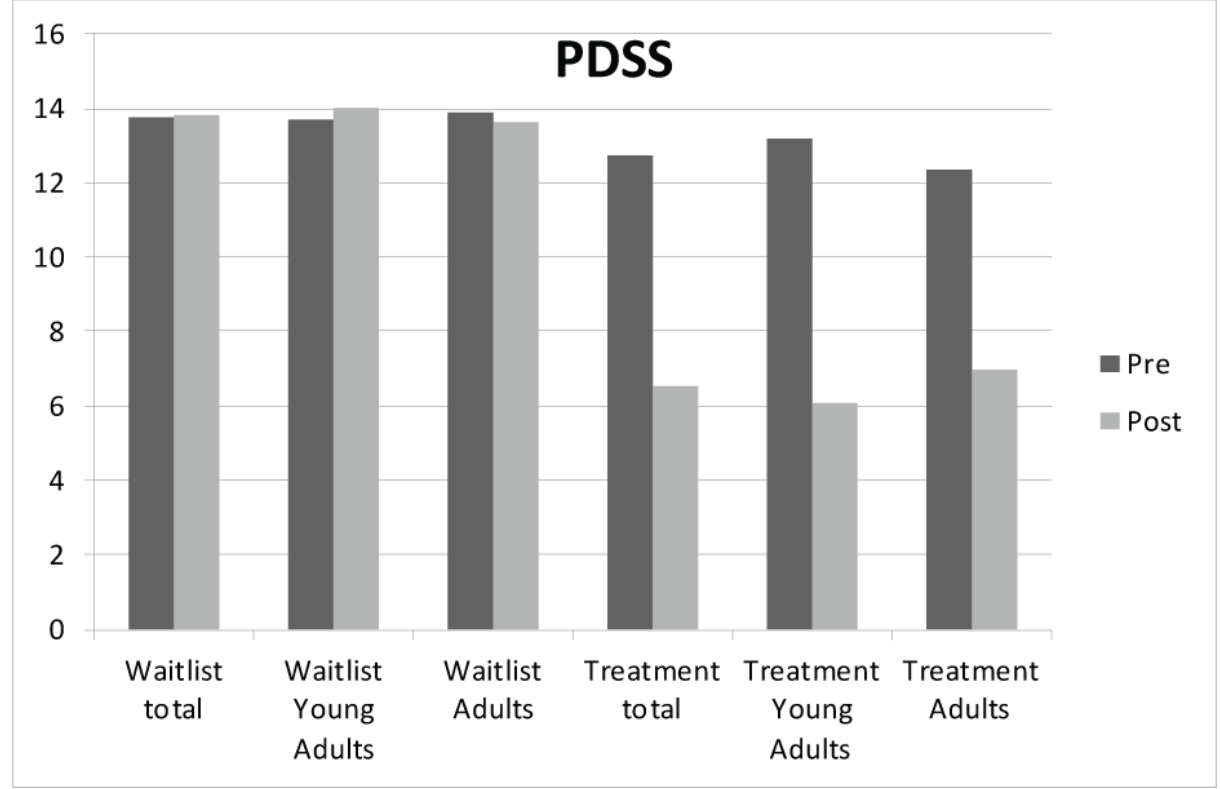
Figure 2. Change in observed mean scores in the Panic Disorder Severity Scale (PDSS) for the treatment and waitlist conditions and the two age groups pre- and